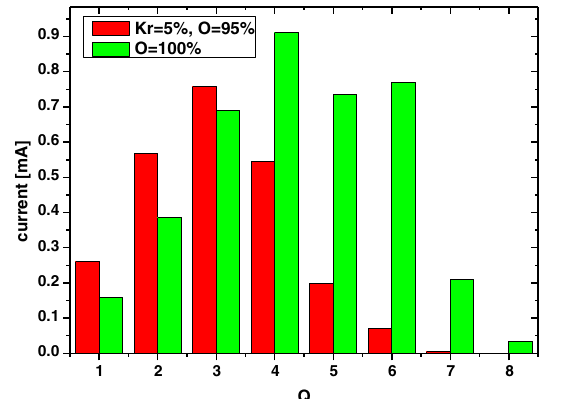
FIG. 9. Charge state distribution of extracted oxygen ion currents for oxygen plasma and for the mix with krypton (Kr ¼ 5 %, O ¼ 95 %).